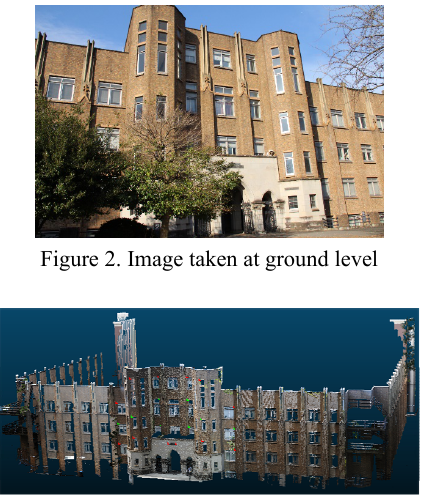
Figure 3. Laser scanner data for evaluation Table 1. Camera specifications